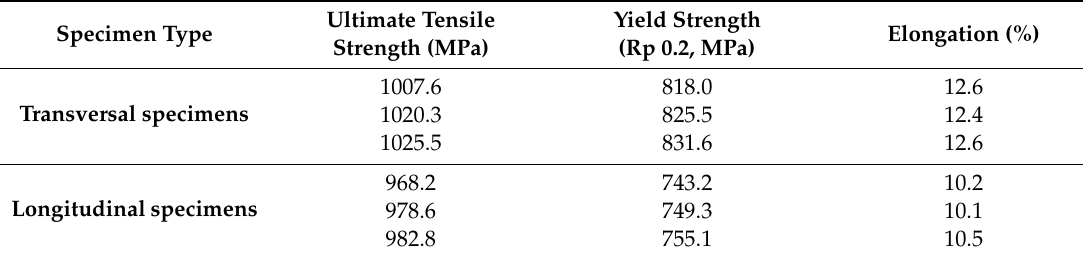
Table 3. Transversal and longitudinal tensile properties.